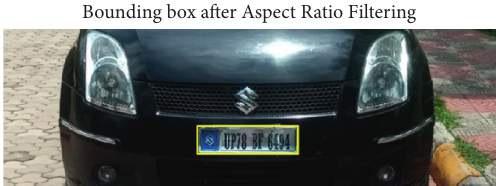
Figure 16: Detected number plate after aspect ratio filtering.